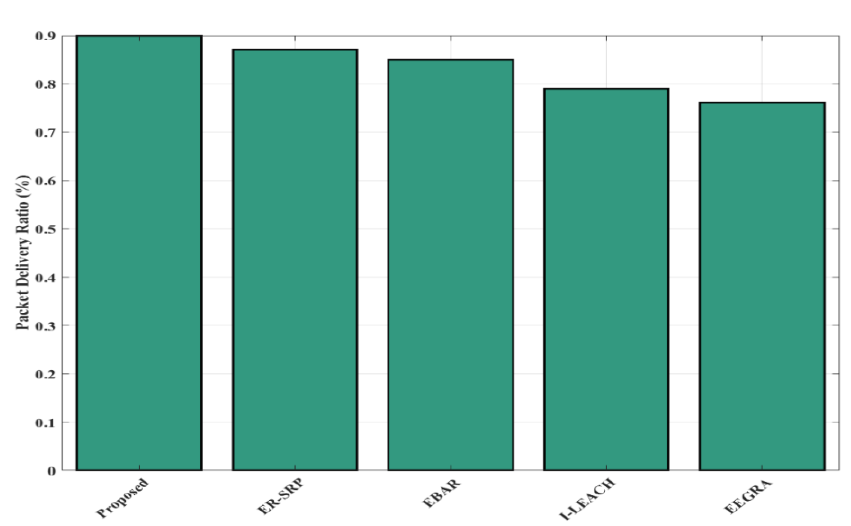
Figure 11. Comparison of packet delivery ratio.